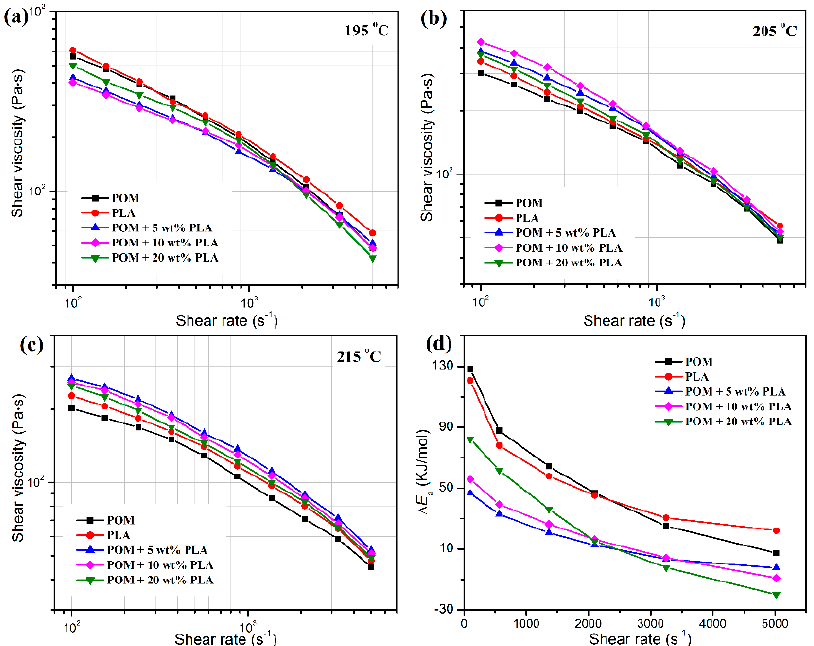
Figure 2. ( a – c ) Plots of shear viscosity as a function of shear rate for polyoxymethylene /poly(L-lactic acid) (POM / PLLA) blends at di ff erent temperatures; ( d ) flow activation energy of pure POM, PLLA acid) (POM/PLLA) blends at different temperatures; ( d ) flow activation energy of pure POM, PLLA and their blends. and their